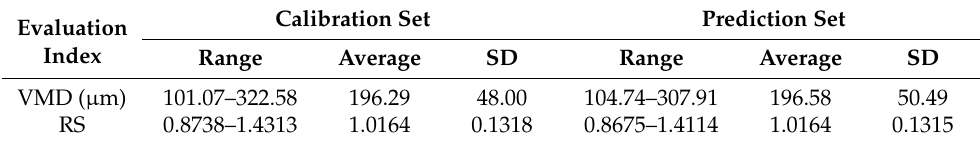
Table 6. Statistics on sample set partitioning.